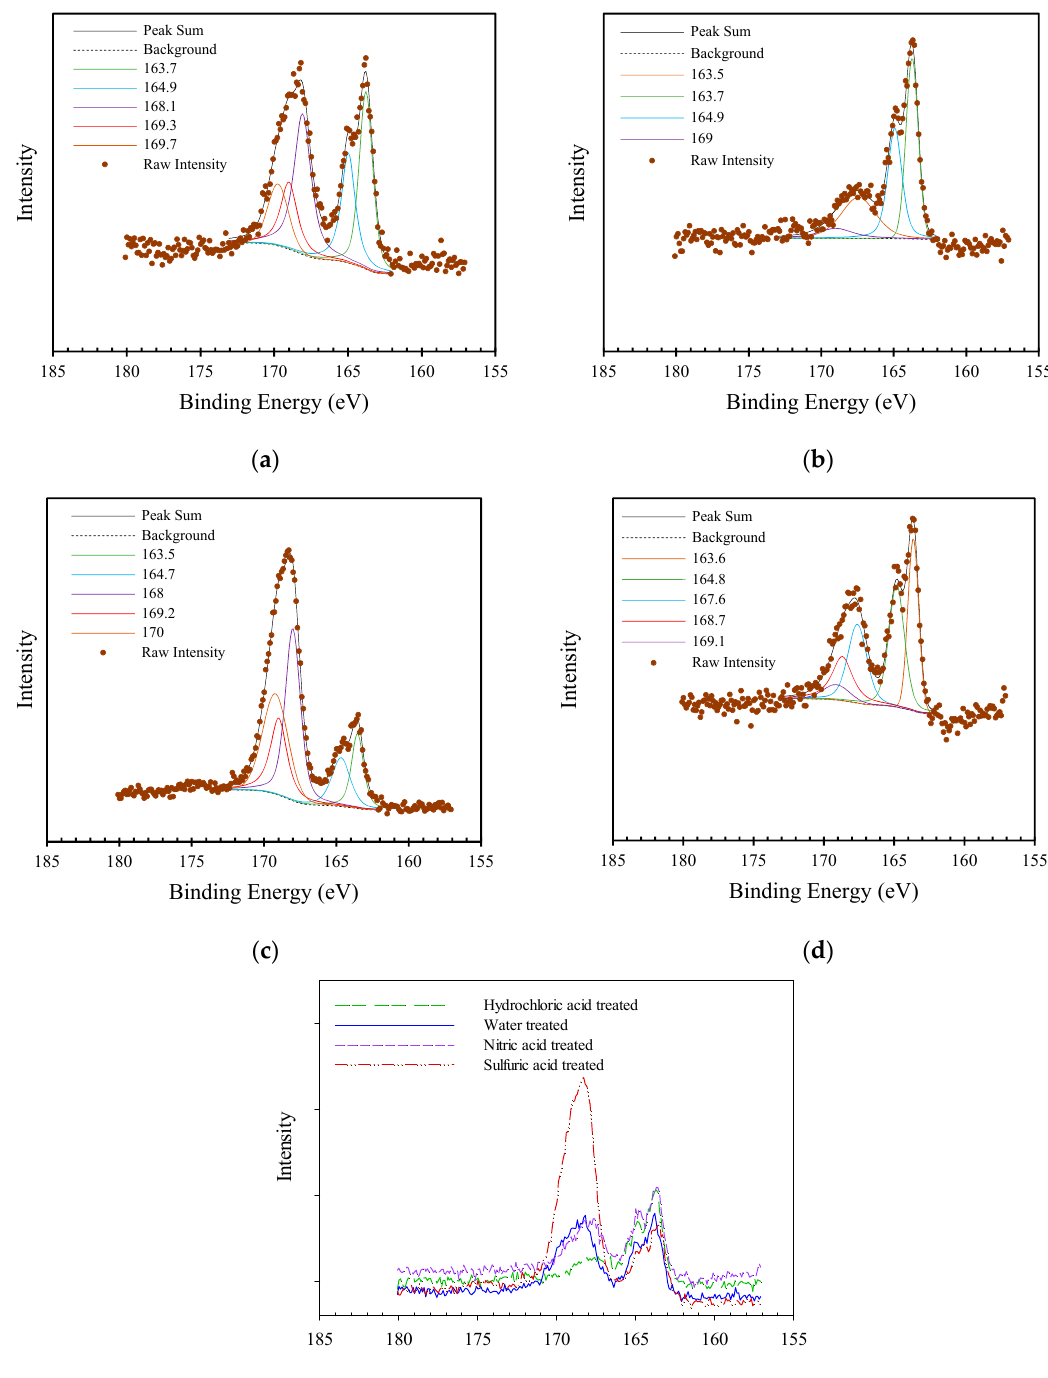
Figure 5. XPS spectra of sulfur 2p peak for different AF 5 treatments: ( a ) Water-treated ( b ) Hydrochloric acid-treated, ( c ) Sulfuric acid-treated, ( d ) Nitric acid-treated, ( e ) Raw data comparison.